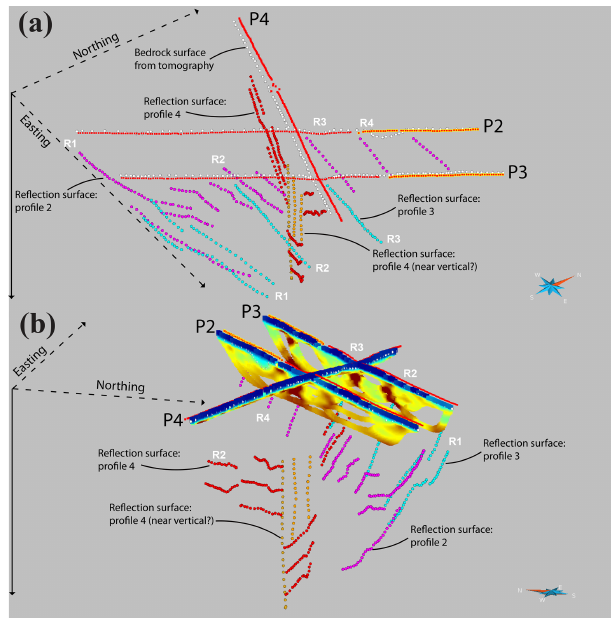
Figure 13. 3-D views showing the interpreted bedrock surface (white points), reflections from profile 2 (purple points), profile 3 (blue points) and profile 4 (red and brown points, likely vertical faults). Note that the red/yellow points on the surface represent the actual locations of the seismic